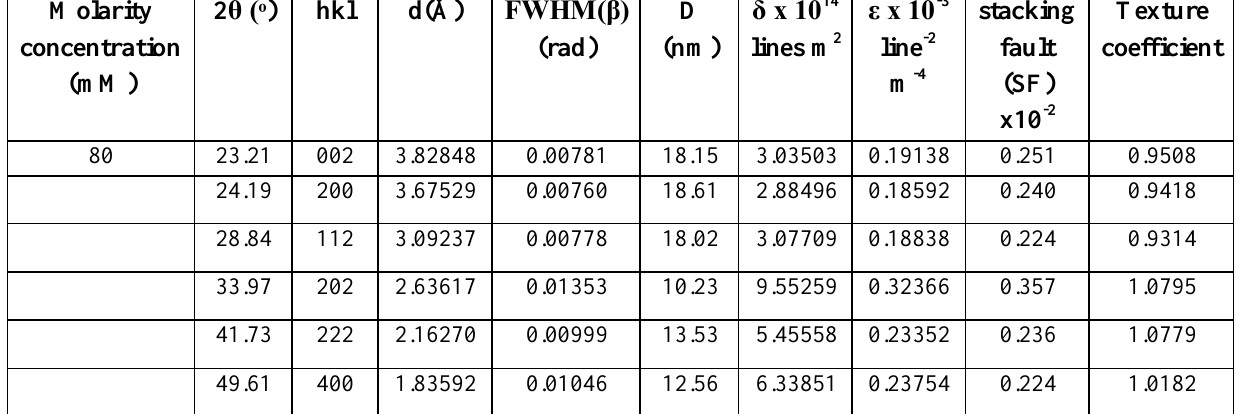
Table 2 : The structural properties of WO 3 thin films at an optimal concentration of